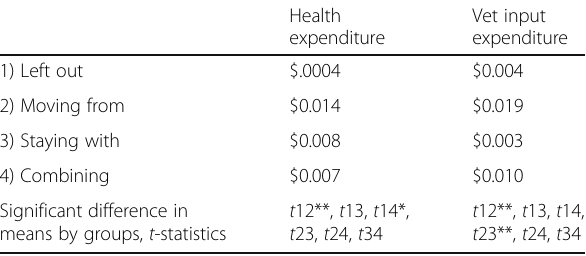
Table 9 Health and veterinary input expenditure per season